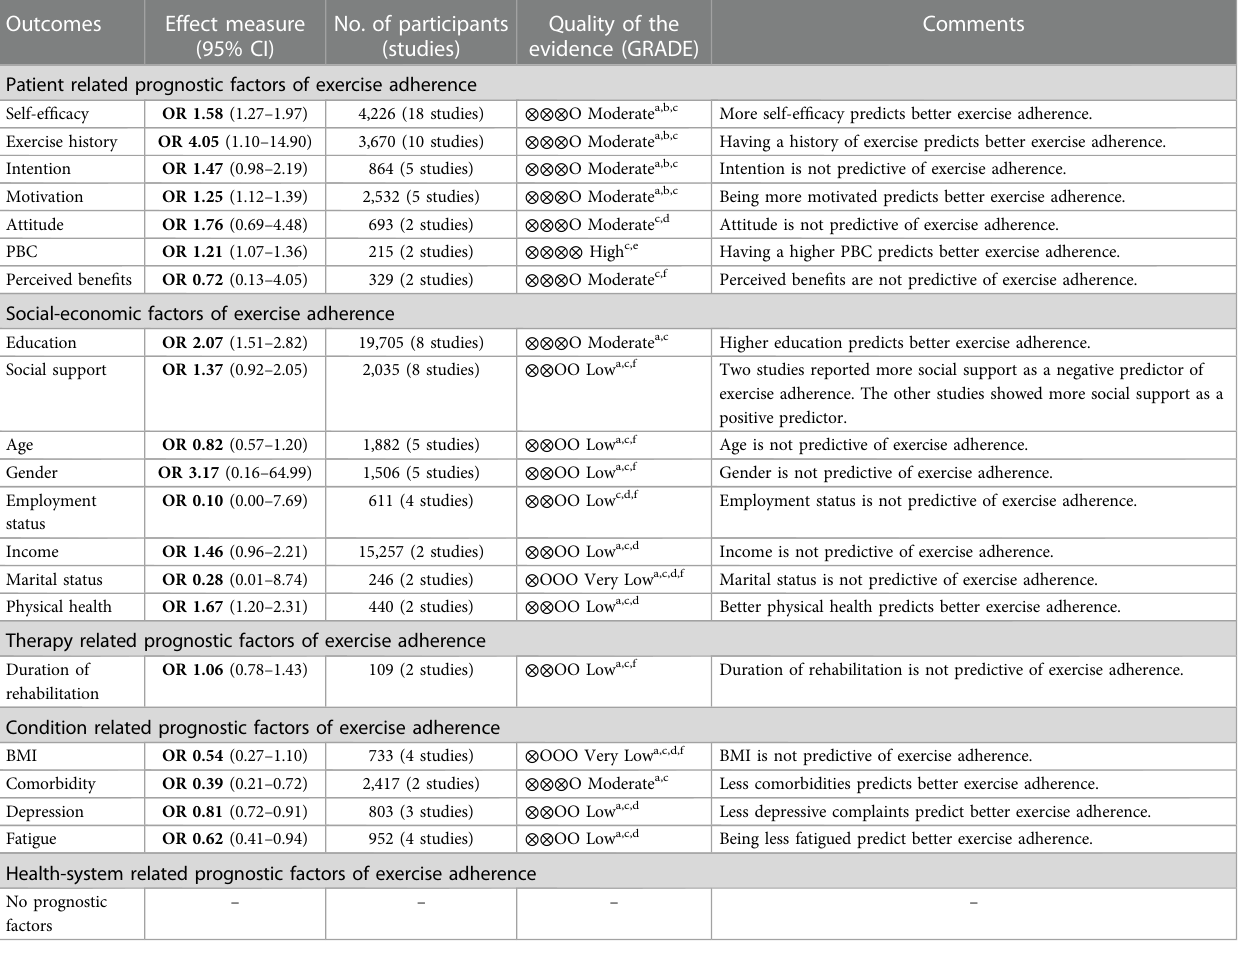
TABLE 1 Summary of fi